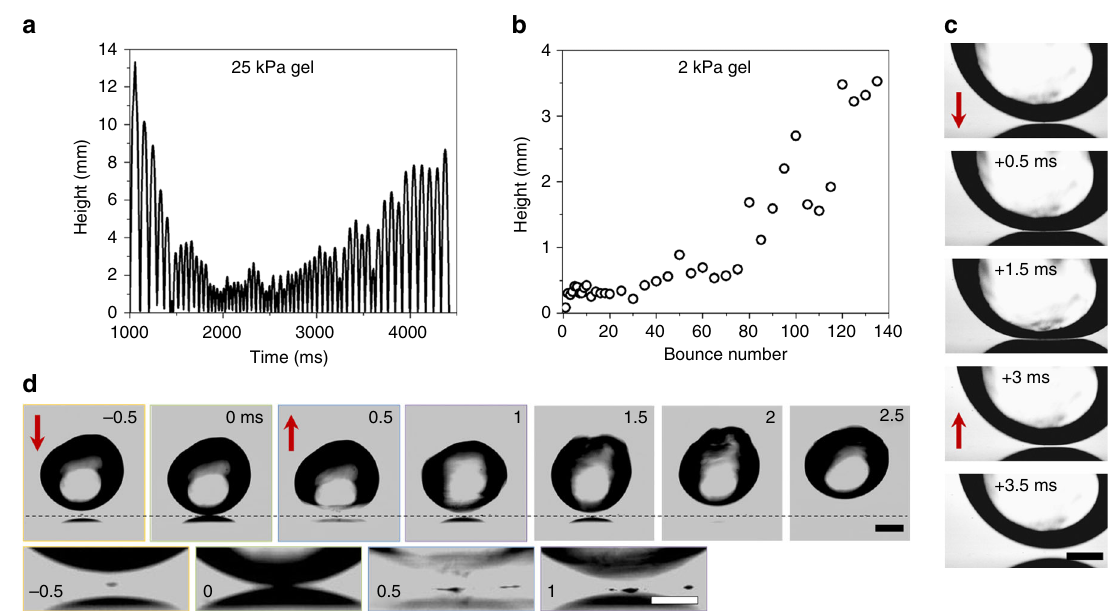
Fig. 4 Subsequent bouncing and trampolining. a Height vs. time for a 25 kPa hydrogel drop after the initial jump illustrating subsequent bouncing (Supplementary Movie 8). After 4.5 s, the drop has bounced outside the fi eld of view. b Height vs. bounce number for a 2 kPa hydrogel after burning the interface (Supplementary Movie 4). c An example of Leidenfrost type contact with an impact velocity of v ≈ 0.15 m s − 1 and a surface temperature ≈ 400 °C. A vapor layer is visible underneath the hydrogel separating the drop from the surface. Scale bar: 0.5 mm. d An example of a pressure-induced pulse type contact (Supplementary Movie 9) of a hydrogel with an impact velocity of v ≈ 0.25 m s − 1 and a surface temperature ≈ 190 °C. Time between images is 0.5 ms. Red arrows illustrate direction of the hydrogel. Scale bar: 1 mm. Insets are zoom-ins of contact zone with labeled times. Scale bar: 0.5